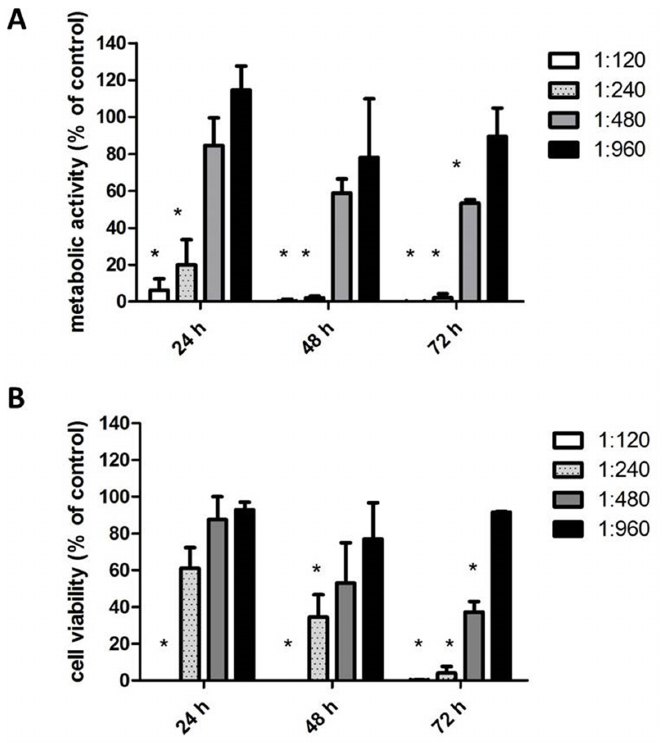
Fig 2. Effect of Rosmarinus officinalis extract on A375 melanoma cells. (A) Metabolic activity (MTT test). (B) Cell viability (Trypan blue exclusion test). Data are expressed as % of cell survival with respect to control. Results are the mean ± SD from three independent experiments. * P (cid:1) 0.05 versus vehicle control.